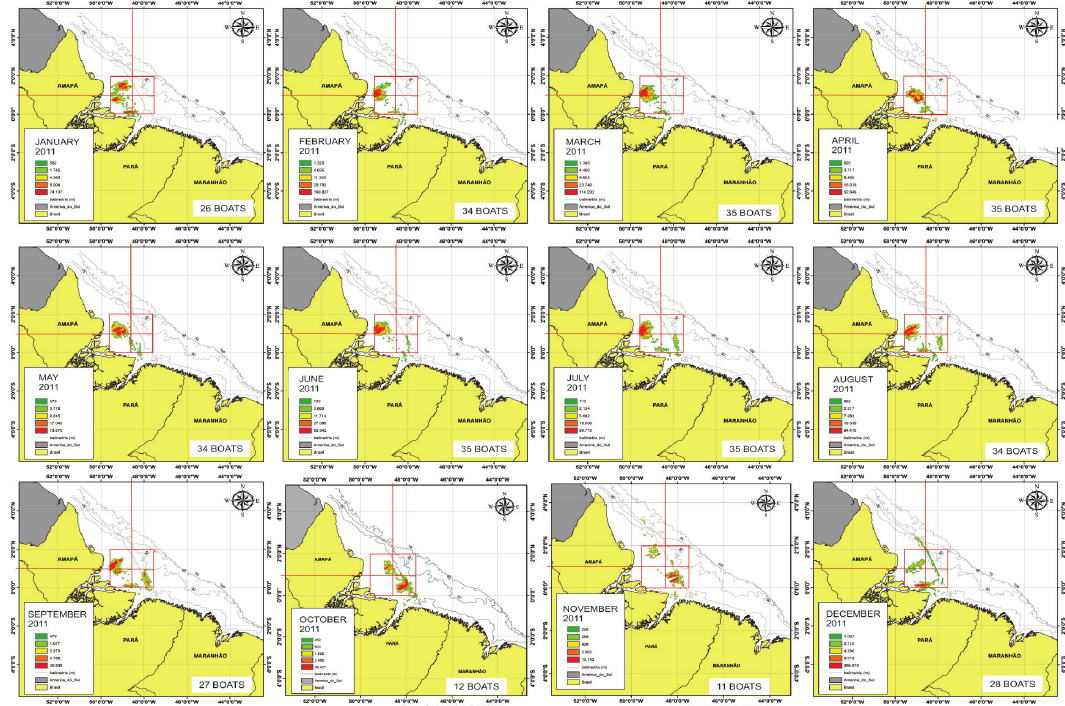
Figure 10. Relative density of fishing activity during the months of 2011 and fishing fleet dynamics divided by quadrant.